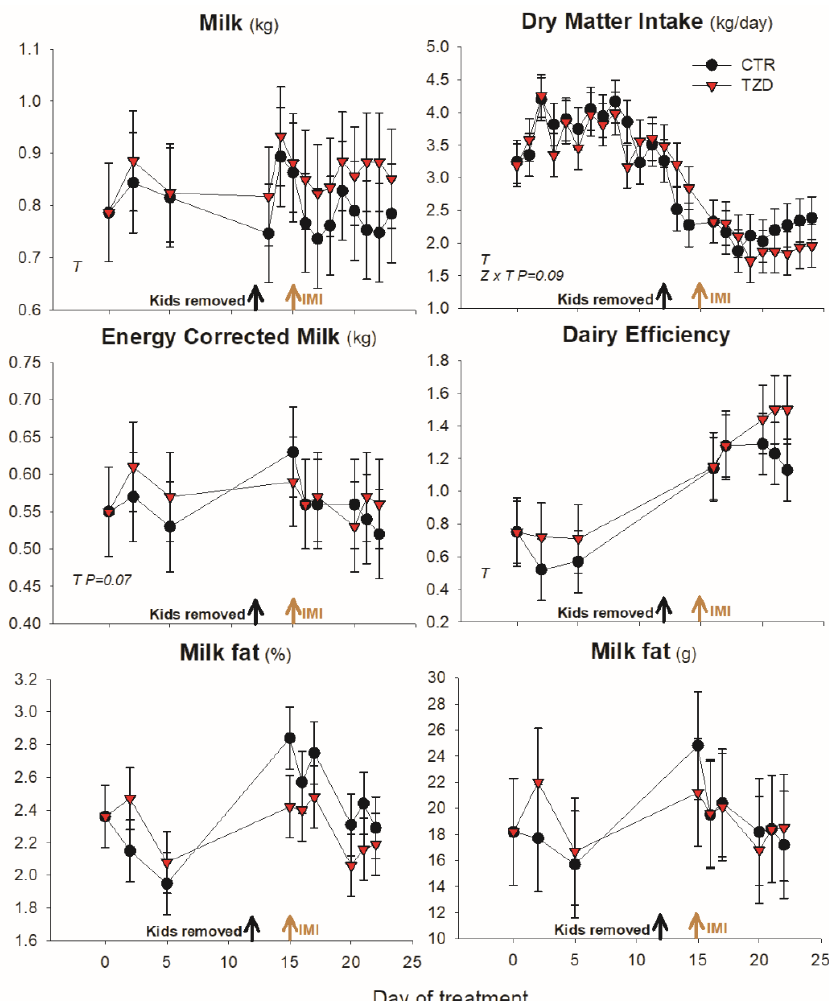
Figure 2. Milk yield (kg produced by the left mammary gland in the AM milking), energy corrected milk, dairy e ffi ciency, daily dry matter intake, milk fat and milk yield (produced by the left mammary gland in the AM milking) in goats receiving daily intra-jugular injection of 2,4-thiazolidinedione (TZD) or saline (CTR). Arrows indicate the time of kid removal and intramammary infusion of Strep. uberis in the right half of the mammary gland (IMI). Letters in the graph denote significant ( p < 0.05) e ff ects of time (T), treatment (Z), and interactions (Z × T). The reported p -value is for tendencies. Error bars denote SEM.